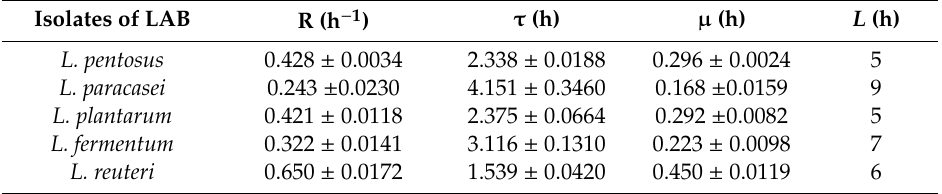
Figure 2. Growth curves of lactic acid bacteria (M ± S E , n = 5): data gained by the Bioscreen C spectrophotometer ( A ) and designed by CFU values ( B ). Table 2. The average generation time( τ ), division ratio (R), lag time (L), and specific growth rate ( µ ).